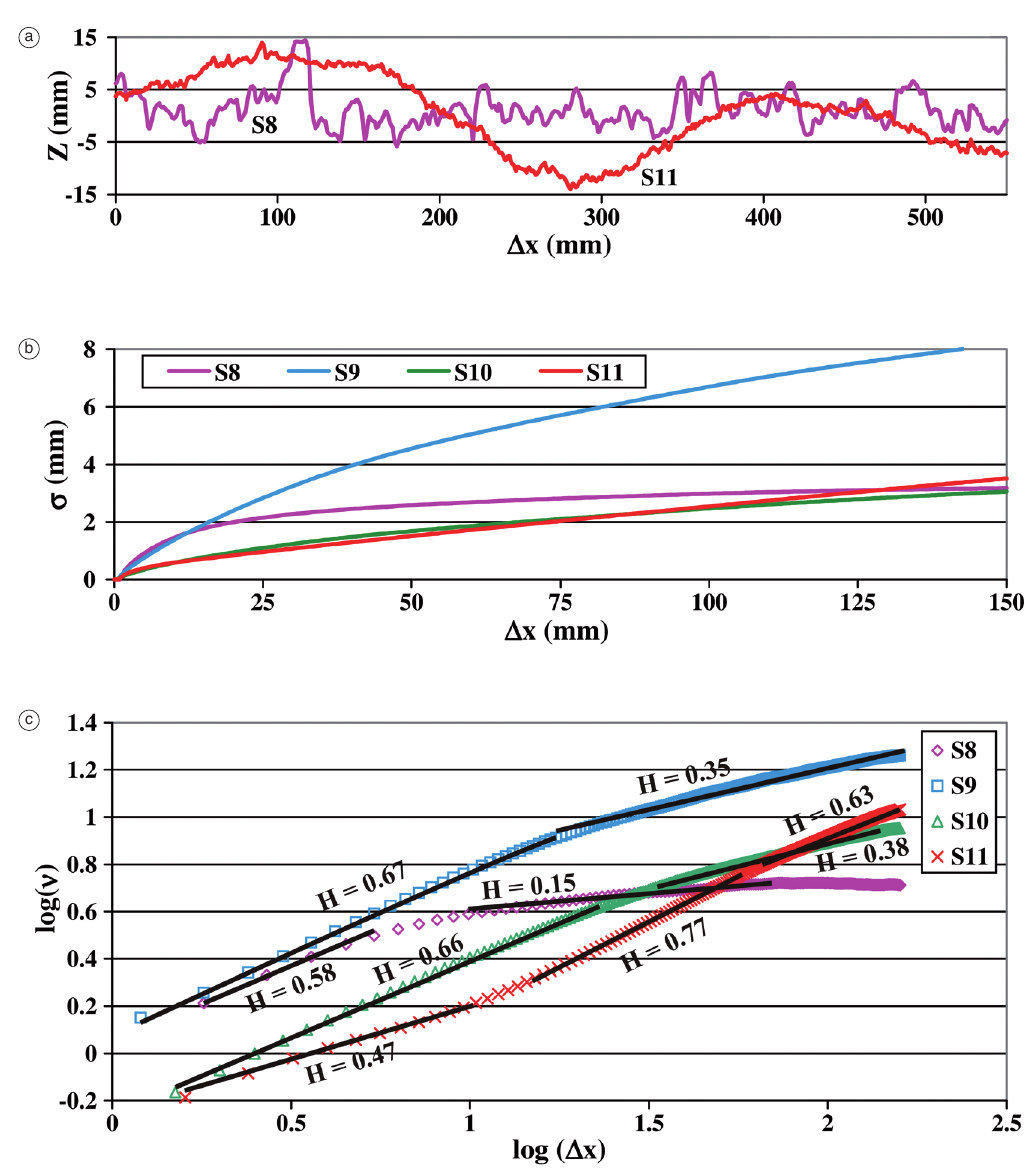
Fig. 4a-c. a) Plot of elevations ( z ) versus length ( Δx ) along de-trended horizontal profiles in the middle of the surfaces of samples S8 and S11. Note that large wavelength dominates in the distribution of heights in the S11 surface. b) Plot of σ ( Δx ) versus Δ x for the sampled surfaces. At Δx lower than few centimetres, the surfaces S11 and S10 have lower σ values than S8 and S9 (see text for discussion). c) Log( ν ) vs log( Δx ) plots for the sampled surfaces. The slope of the curves defines the Hurst exponent ( H ). In each curve, the best fit linear lines are outlined and the relative H values are reported. For each sample different H values exist at different scale range (see